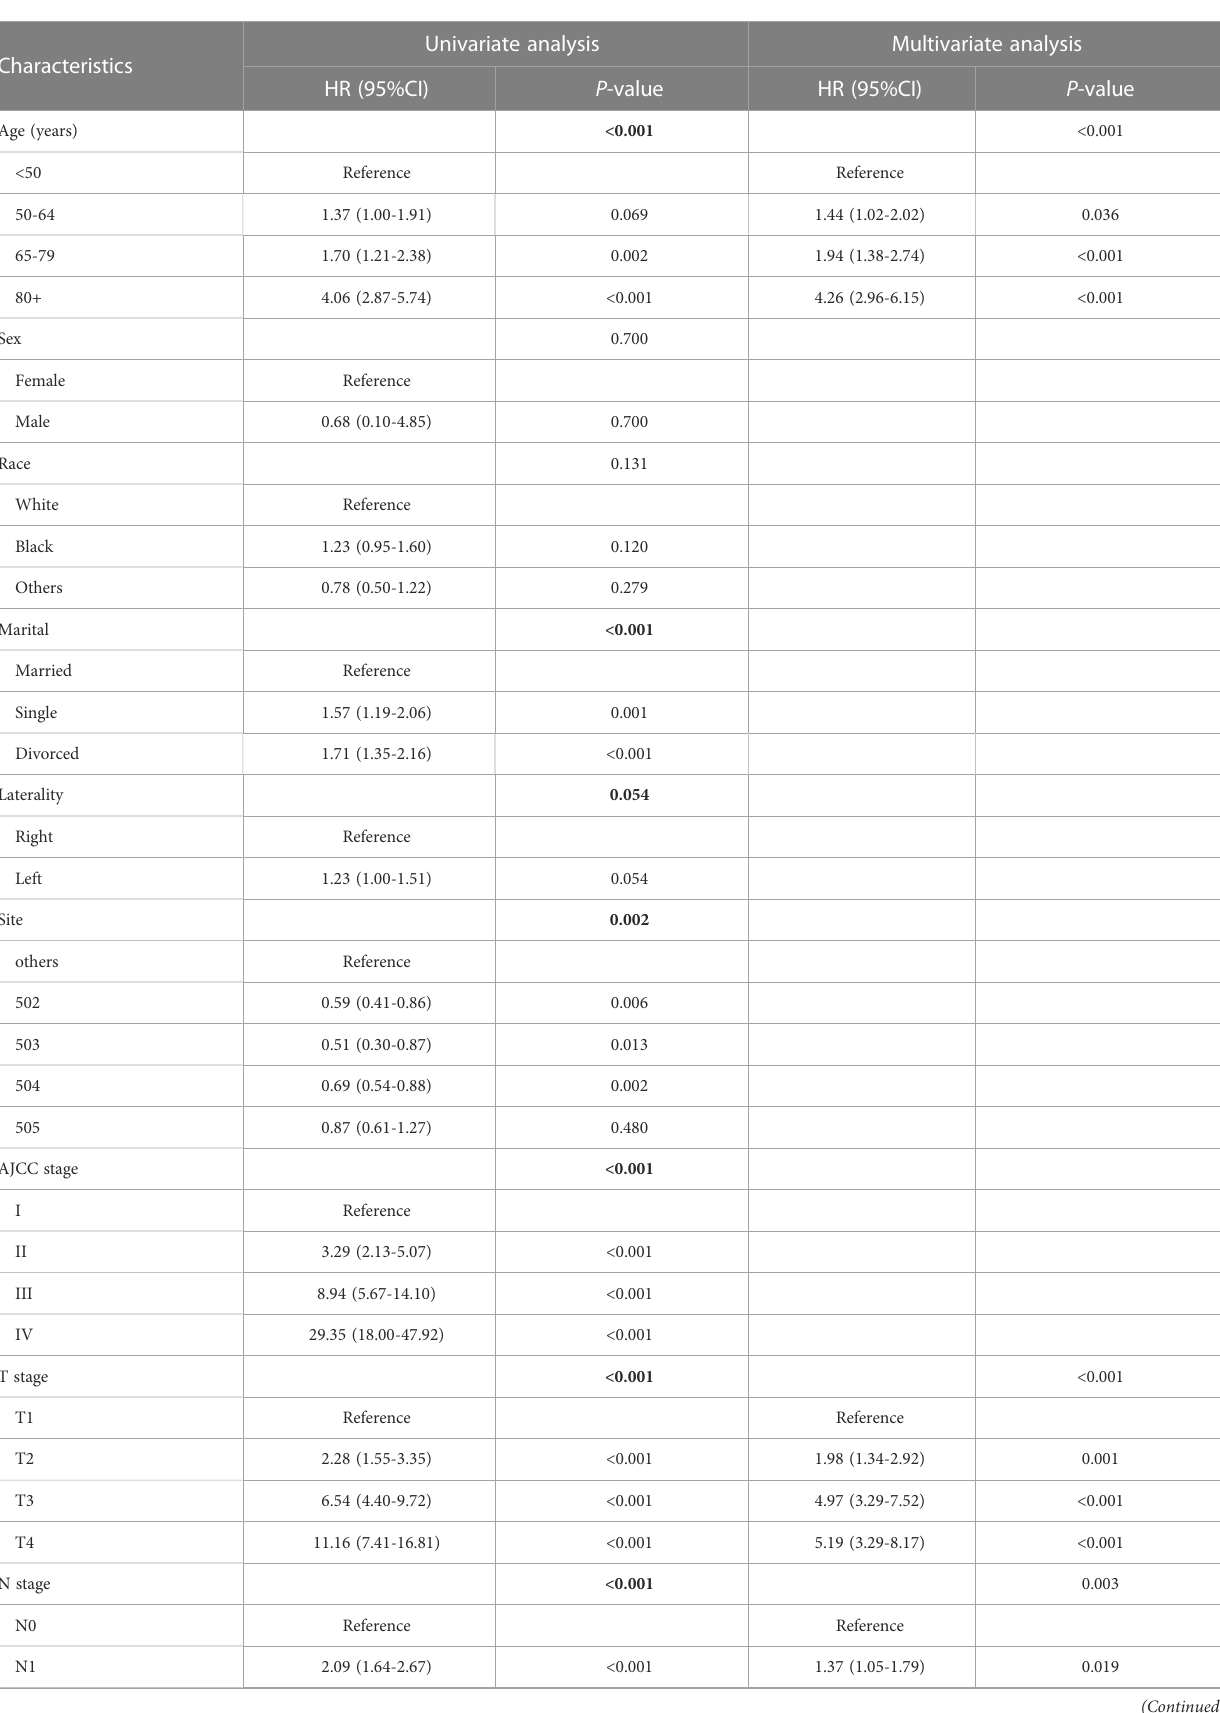
TABLE 2 Univariate and multivariate Cox regression analysis of overall survival (MBC Training